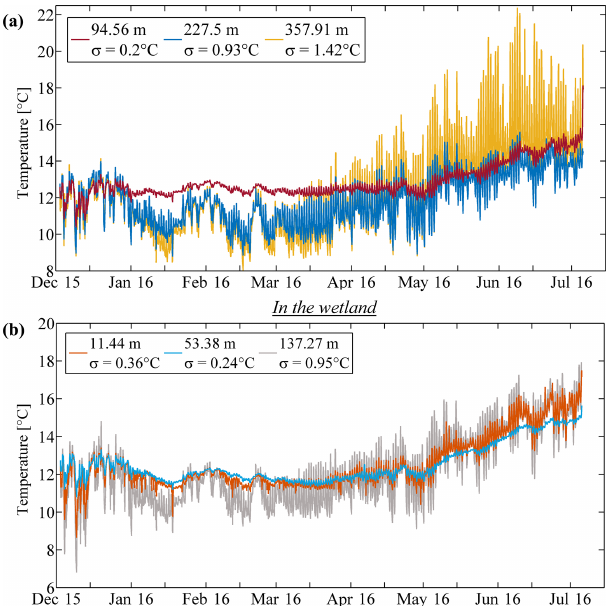
Figure 5. Examples of streambed temperature variations measured with the FO-DTS (a) at 94.56, 227.5, and 357.91m from upstream, with respective SD values equal to 0.2, 0.93, and 1.42 ◦ C. (b) In the wetland area at 11.44, 53.38, and 137.27m from upstream, with respective SD values equal to 0.36, 0.24, and 0.95 ◦